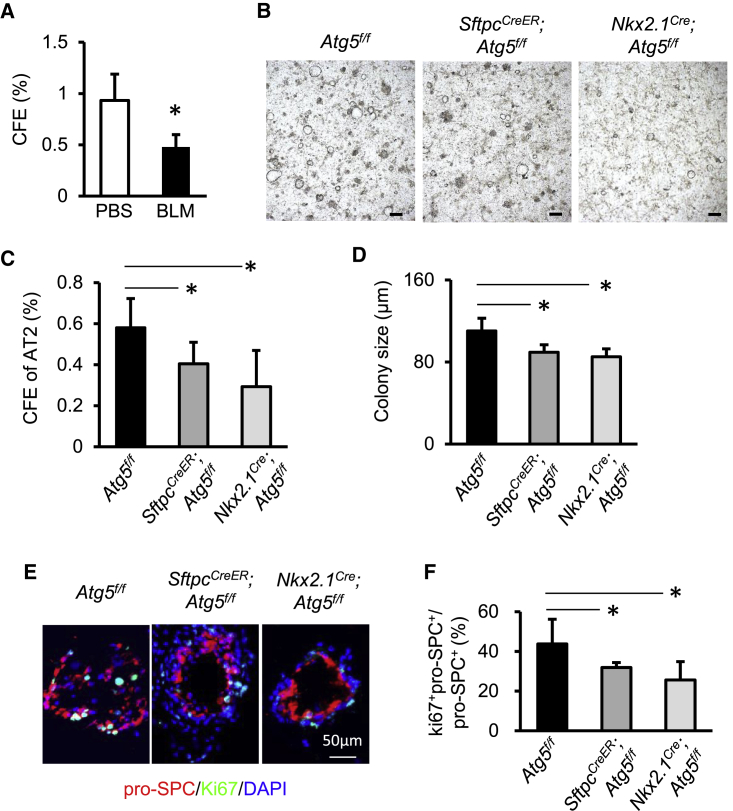
Autophagy Sustains the Proliferative Capacity of AT2 Cells during BLM Injury(A) CFEs of mouse AT2 cells isolated from untreated or BLM-injured Atg5f/f mice at day 10 after seeding (n = 4).(B) Representative micrographs of organoid cultures of mouse AT2 cells isolated from Atg5f/f, SftpcCreER;Atg5f/f (pretreated with tamoxifen), or Nkx2.1Cre;Atg5f/f mice 14 days after BLM injury. Scale bar: 200 μm.(C and D) CFEs (C) and sizes (D) of organoid colonies from Atg5f/f, SftpcCreER;Atg5f/f (pretreated with tamoxifen), or Nkx2.1Cre;Atg5f/f mice at day 14 after BLM injury (n = 4).(E and F) (E) Immunostaining of organoid colonies and (F) quantification of fractions of Ki67+pro-SPC+ cells in total pro-SPC+ cells in AT2 organoids (n = 4). Data are representative of three independent experiments with error bars representing the mean ± SD. ∗p < 0.05.